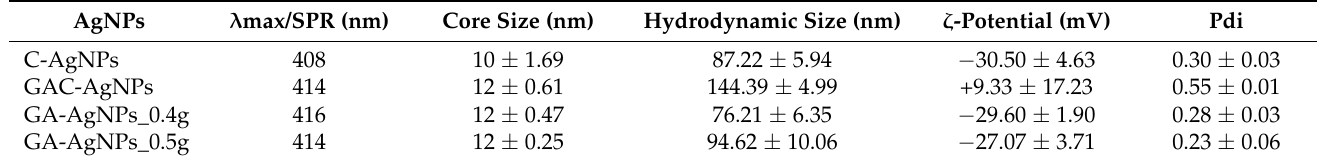
Table 2. Physicochemical properties of the